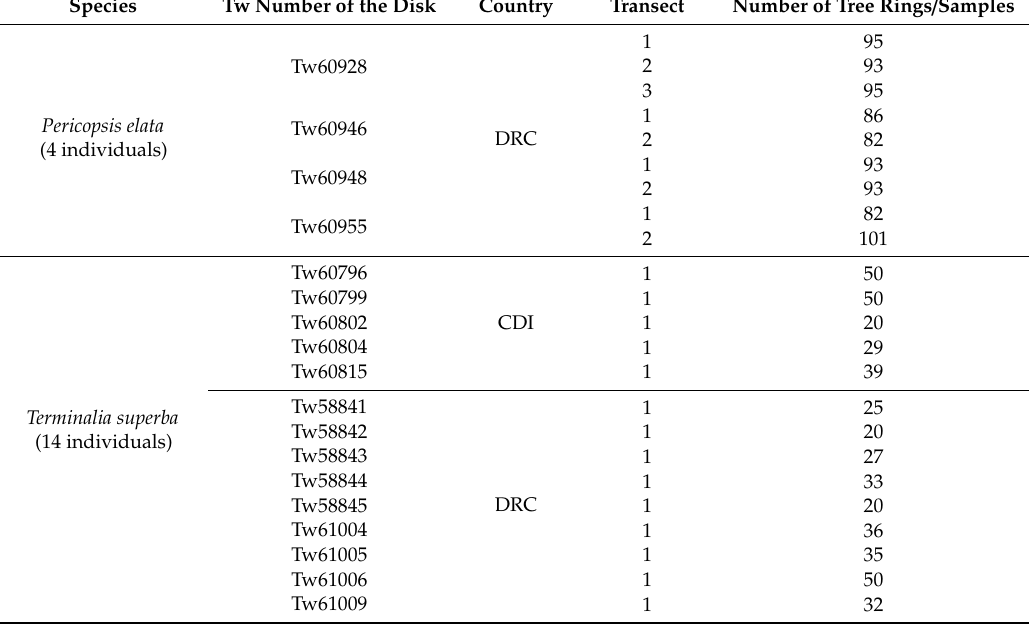
Table 1. Species, Tw accession number (Tervuren Wood collection) for the individual (disk), country (Democratic Republic of the Congo—DRC, C ô te d’Ivoire—CDI), transect and sample number for the wood